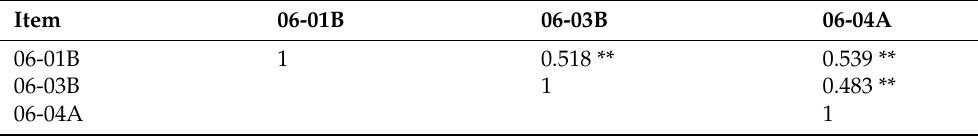
Table 1. Correlation matrix of individual tree-ring δ 13 C series in 1901–2011.